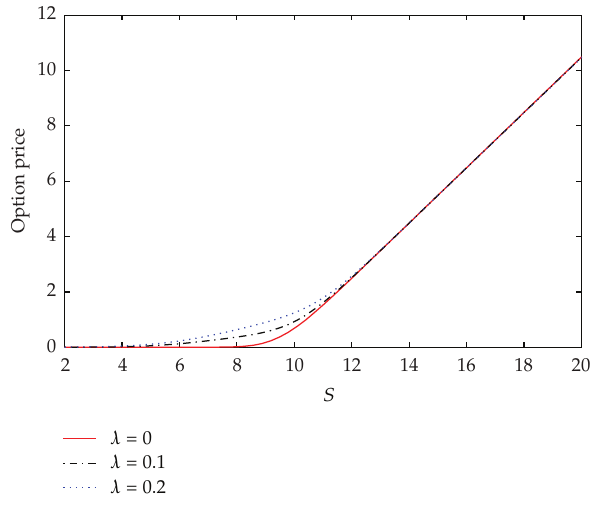
Figure 2: Variation of the jump intensity λ .